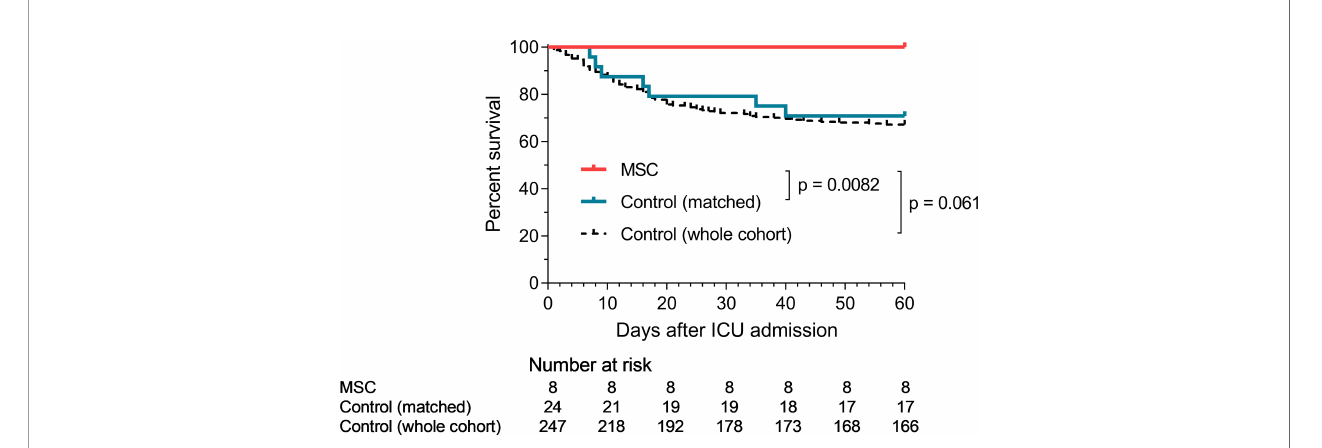
FIGURE 2 | Survival curves in MSC and control groups. p-values refers to comparisons between the MSC and control groups at day 60 (using the Fisher test for non-matched analysis and Wilcoxon test for the matched